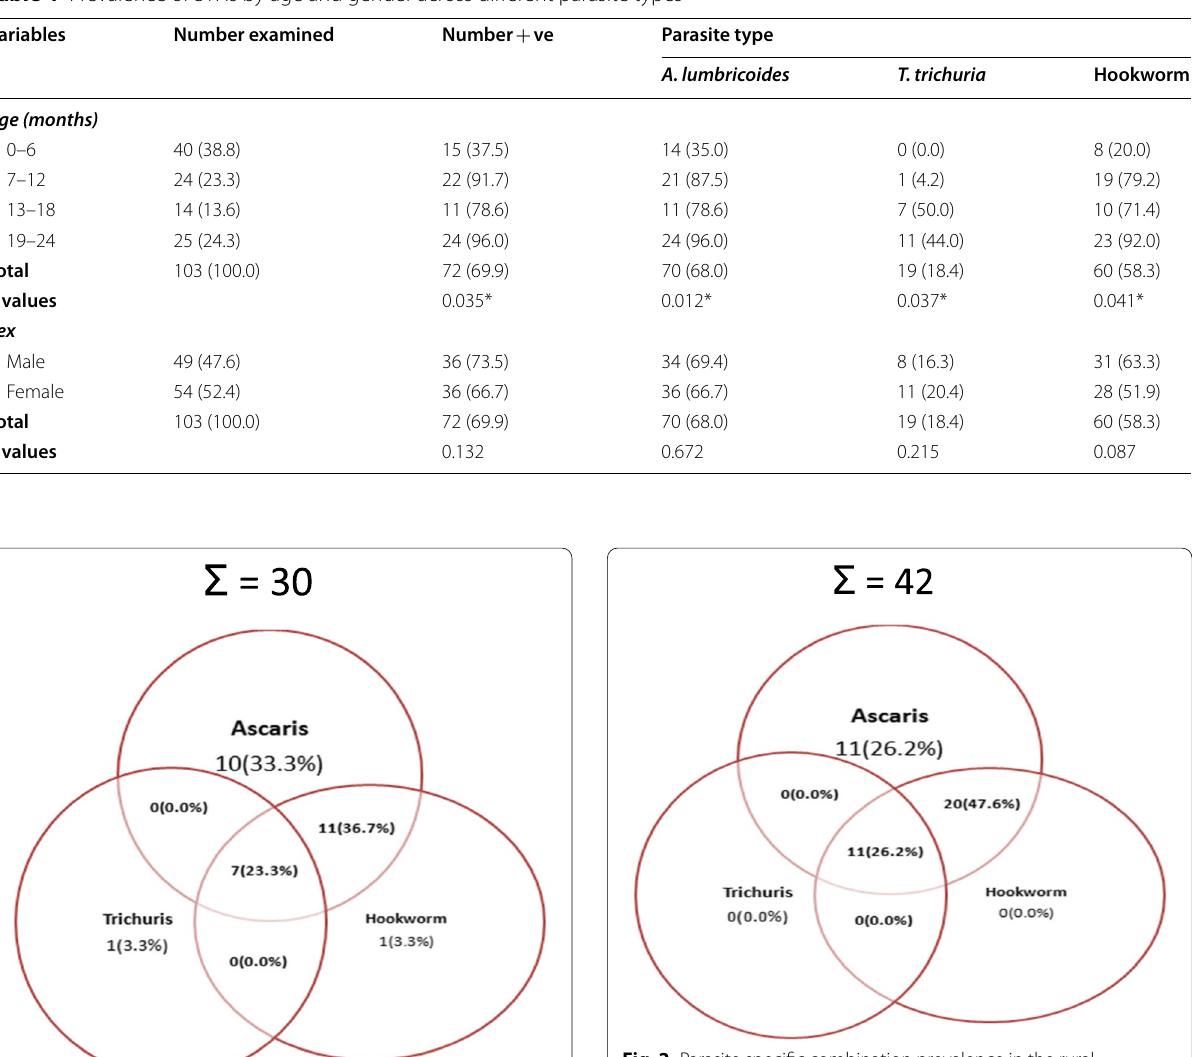
Fig. 2 Parasite specific combination prevalence in the rural